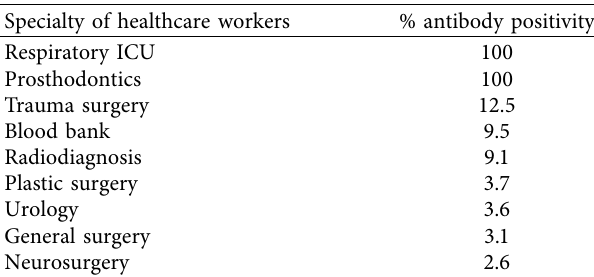
Table 10: Specialty-wise distribution of healthcare